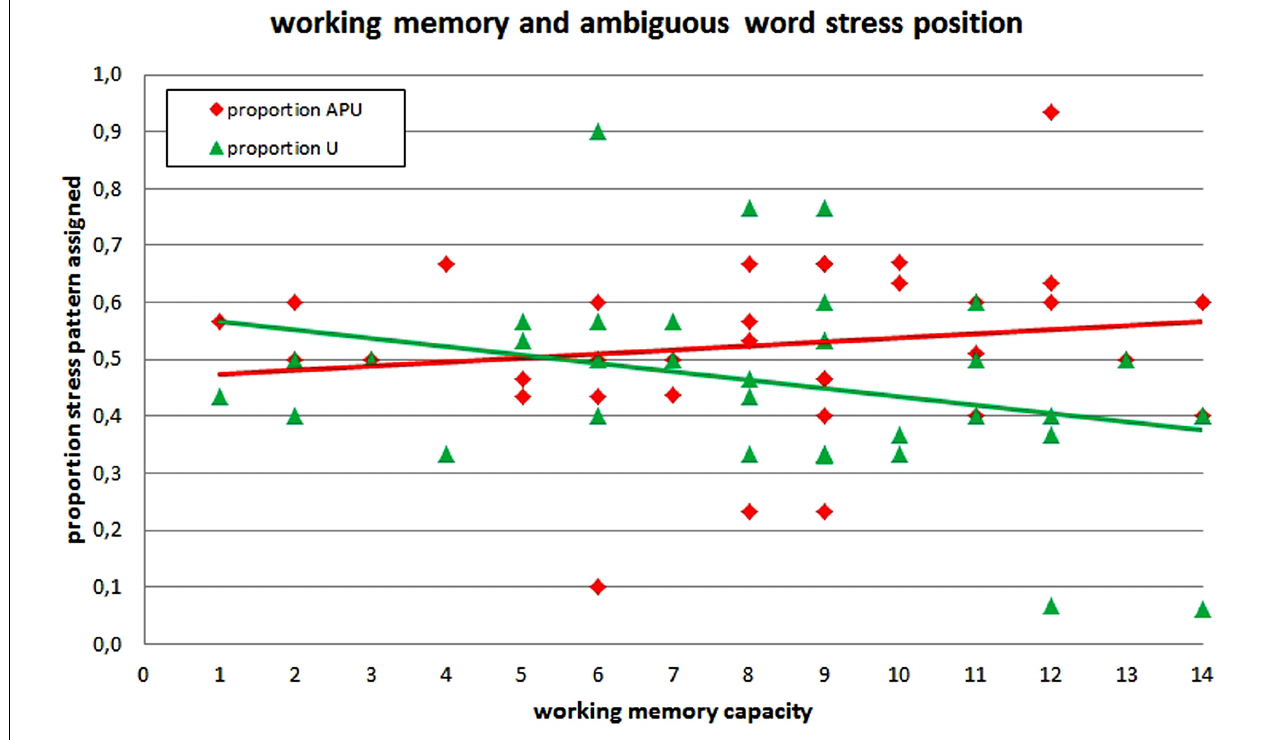
FIGURE 2 |Assignment of main stress in stress ambiguous words as a function of individualWM capacity. (Note that we plotted linear functions in this graph, while we used a non-parametric procedure in actual analyses, which does not assume a linear function.)